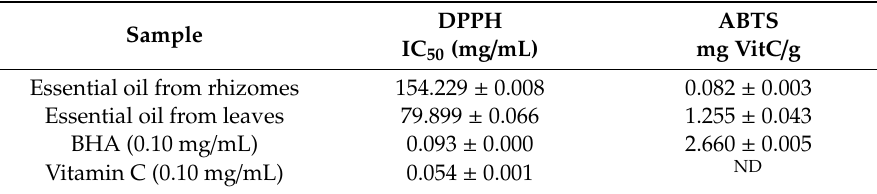
Table 2. Antioxidant activity of the essential oils obtained from rhizomes and leaves of Petasites hybridus subsp. ochroleucus .